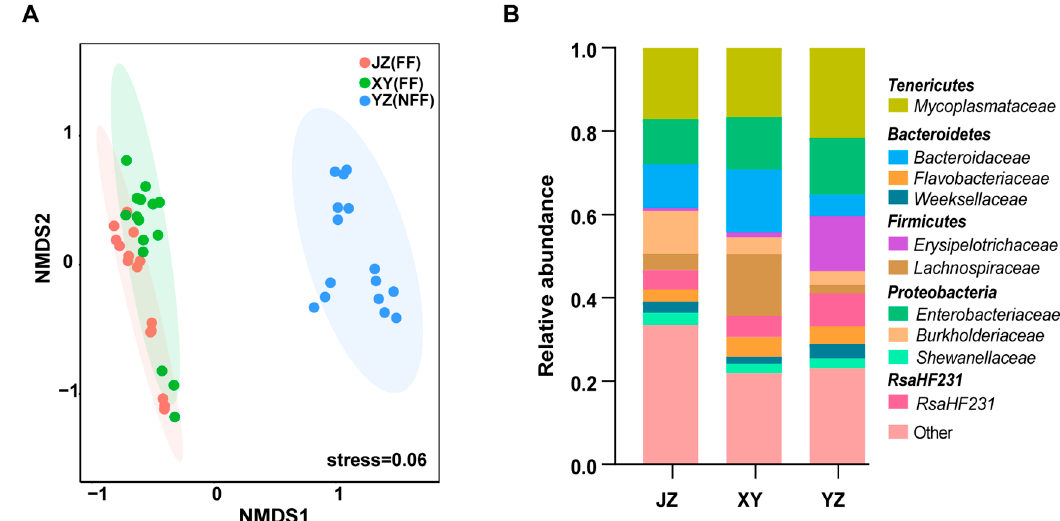
Figure 6. Impact of geography and diet on gut microbiota of crayfish. ( A ) Non-metric Multi-Dimensional Scaling ordination analysis of gut microbiota in crayfishes related to geographic locations. Adonis test, R 2 = 0.122, p = 0.001. Red dots: gut samples of crayfishes from JZ fed with fermented feed; green dots: gut samples of crayfishes from XY fed with fermented feed; blue dots: gut samples of crayfish from YZ fed with non-fermented feed. ( B ) Relative abundances of the dominant bacteria in the guts of crayfish samples from different geographic locations (JZ: Jingzhou; XY: Xuyu; YZ: Yangzhou) at the family level. Table 2. Community dissimilarity test of gut microbiota over crayfish diet and geography based on analysis of similarity (ANOSIM) using Bray–Curtis distance.